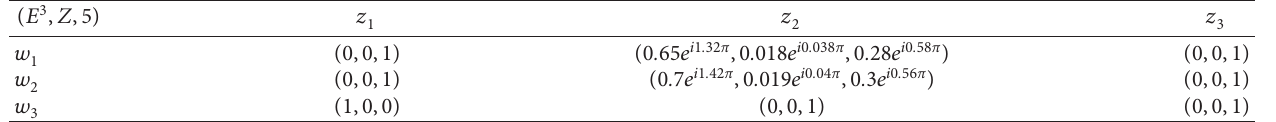
S related with ( E f